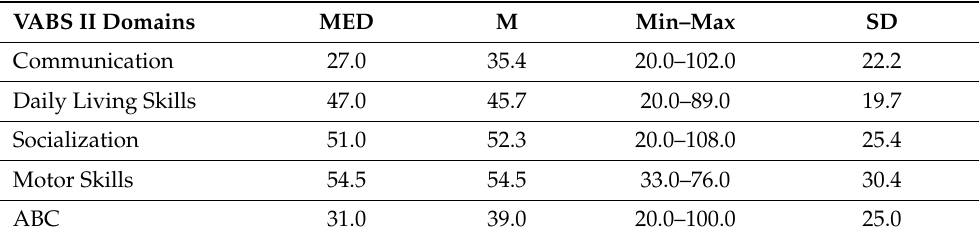
Table 2. Descriptive statistic in VABS II